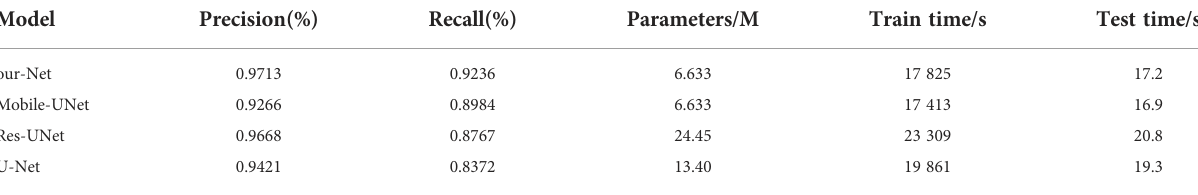
TABLE 2 Comparison of precision, recall, parameters, train time and test time of four different models. Model